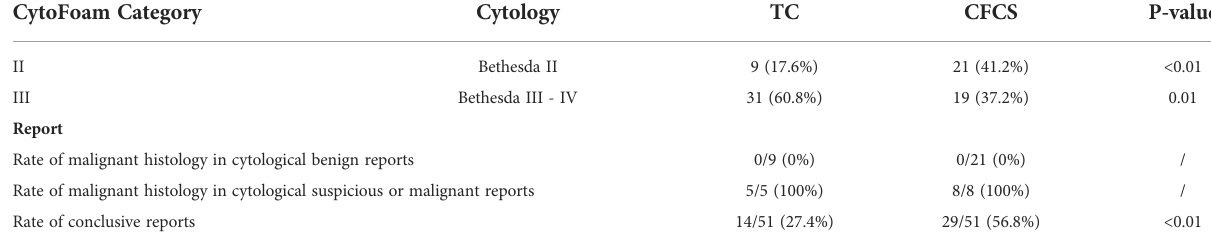
TABLE 7 Statistically relevant results of CytoFoam categories vs traditional cytology classes. CytoFoam